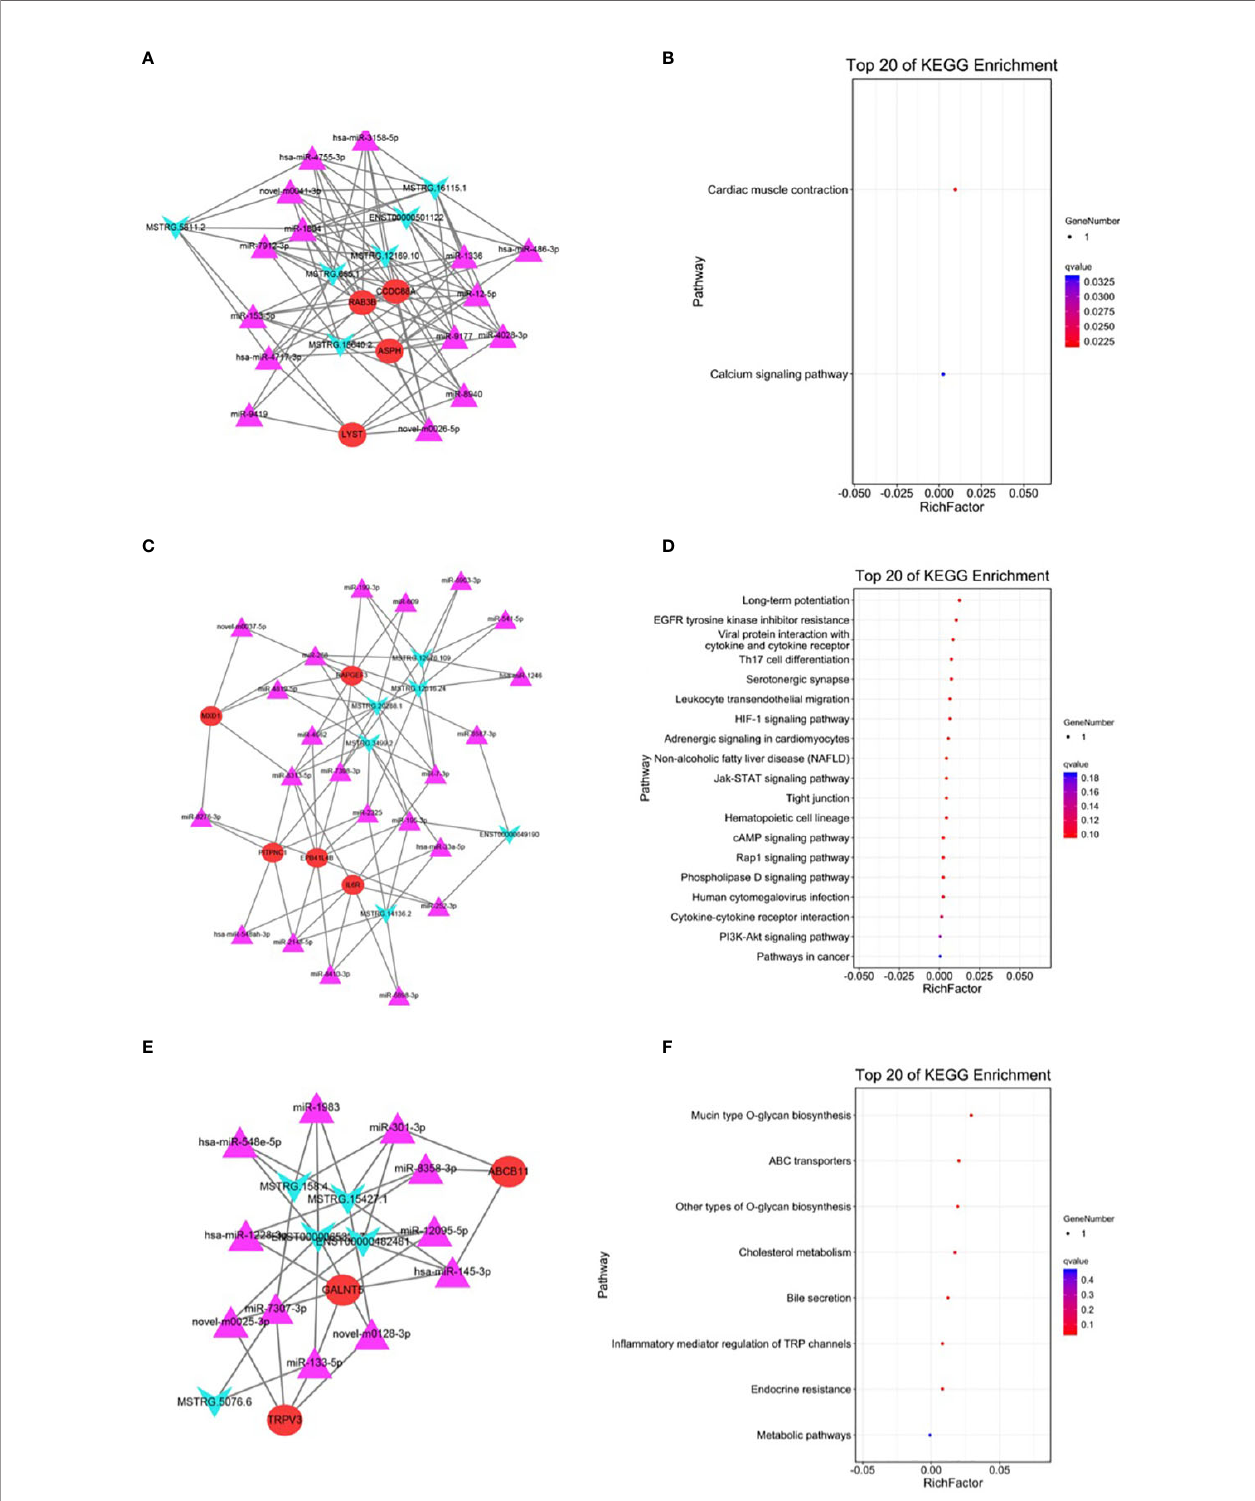
FIGURE 5 | Module analysis and enrichment analysis of the ceRNA network. (A) The ceRNA network of module 1. (B) KEGG enrichment analysis of module 1. (C) The ceRNA network of module 2. (D) KEGG enrichment analysis of module 2. (E) The ceRNA network of module 3. (F) KEGG enrichment analysis of module 3. For panels (A, C, E) , arrow nodes represent lncRNAs, triangular nodes represent miRNAs, and square nodes represent